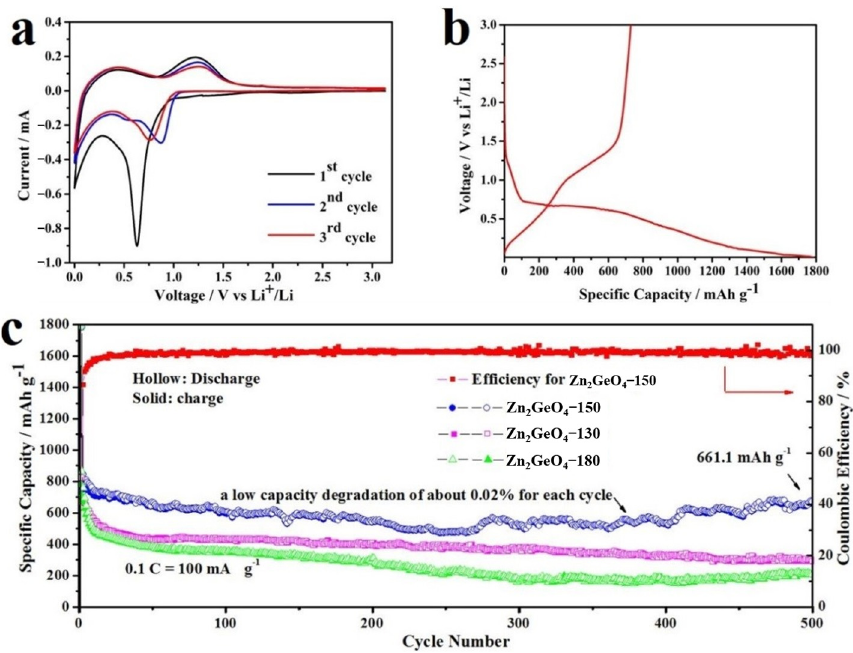
Figure 5. ( a ) CV curves of Zn 2 GeO 4 -150 electrode at 0.1 mV s − 1 . ( b ) The discharge/charging curves of Zn 2 GeO 4 -150 electrode at 100 mA g − 1 . ( c ) Cycling performances of Zn 2 GeO 4 -130, Zn 2 GeO 4 -150 and Zn 2 GeO 4 -180 at 100 mA g − 1 , and Coulombic efficiencies of the main product of Zn 2 GeO 4 -150. The cycle performances of Zn 2 GeO 4 -130, Zn 2 GeO 4 -150, and Zn 2 GeO 4 -180 electrodes The rate capabilities of Zn 2 GeO 4 -130, Zn 2 GeO 4 -150, and Zn 2 GeO 4 -180 are